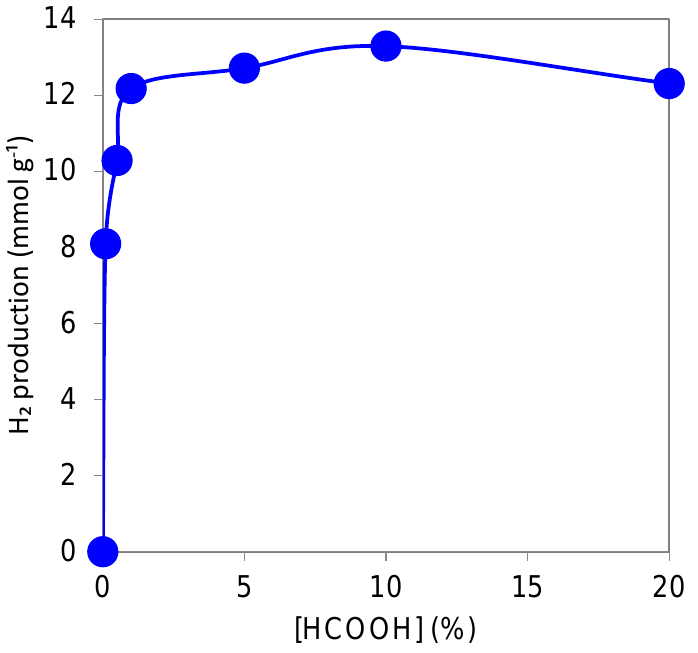
Figure 3. Effect of formic acid concentration. TiO 2 , 50 mg; Rh, 1.25 ppm; reaction time, 3 h; reaction temperature, 50 °C.